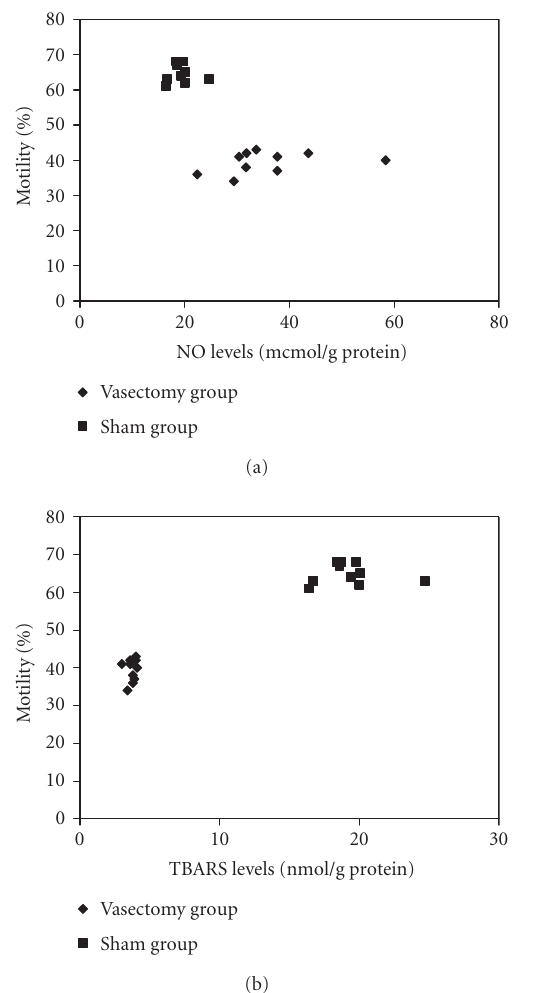
Figure 1: Correlation between sperm motility and seminal plasma NO (a) and TBARS (b) levels in both groups.